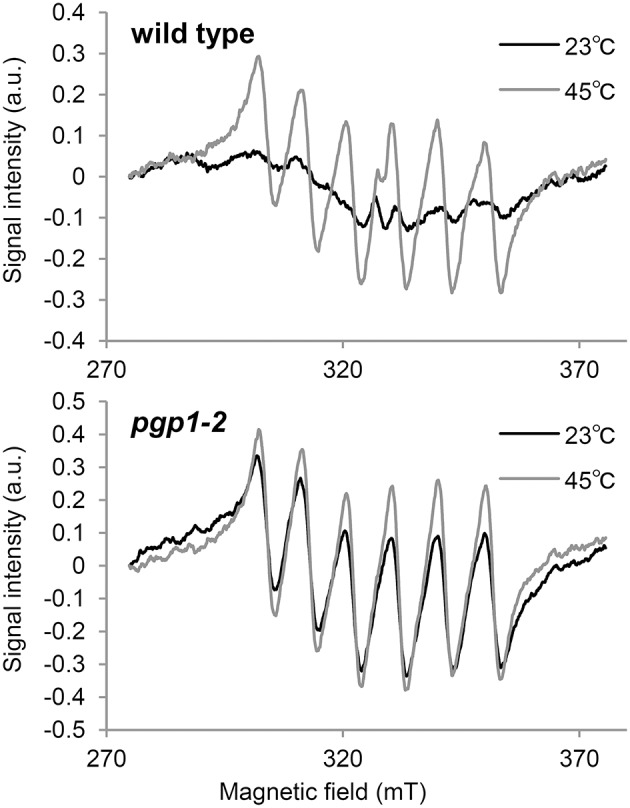
Electron paramagnetic resonance spectra of Mn2+ in leaves incubated for 23 or 45°C for 16 h. Signal intensity was normalized to fresh weight of the samples. Data are means from 3 independent experiments.